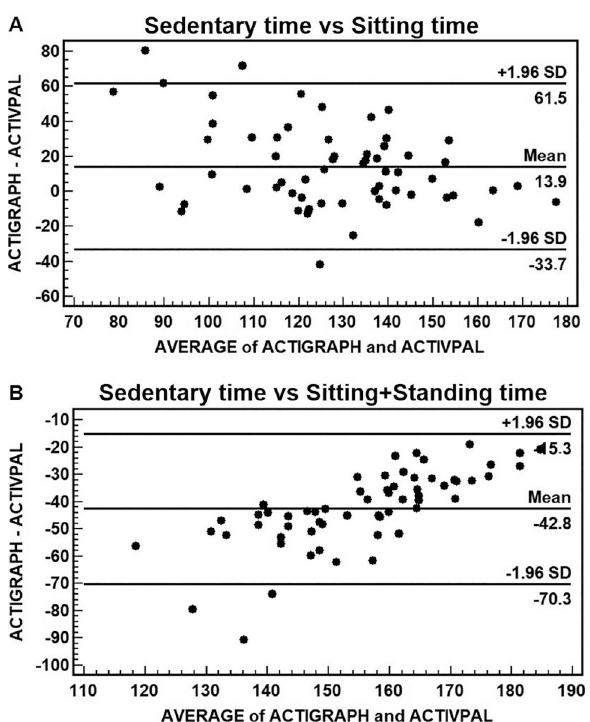
Figure 2 - Bland-Altman plots of the differences between ActiGraph GT3X and ActivPAL: A - Sedentary time from ActiGraph GT3X versus Sitting time from ActivPAL. B - Sedentary time from ActiGraph GT3X versus Sitting and Standing time